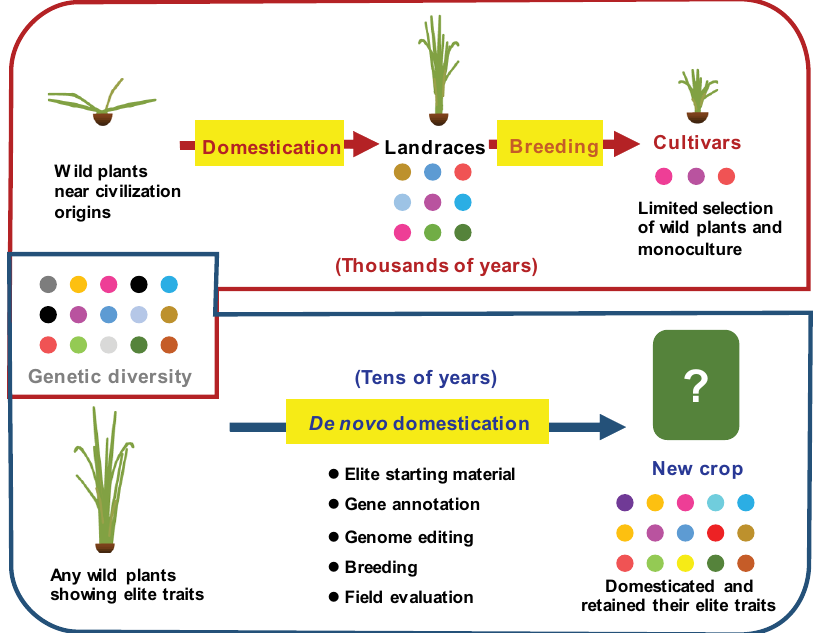
Fig. 1 De novo domestication as a promising route in creating future crops. Crop domestication and breeding are critical for the survival and development of human civilization, which cost thousands of years to change the wild plants in civilization origins to modern cultivars; however, the genetic diversity, represented by different color of dots, is greatly reduced due to the intensive selection of wild plants and monoculture of elite varieties. With the technology revolutions, de novo domestication has been proposed and practiced to meet future agricultural challenges, which can speedily select and domesticate elite wild plants while retaining the genetic diversity and the associated elite traits.